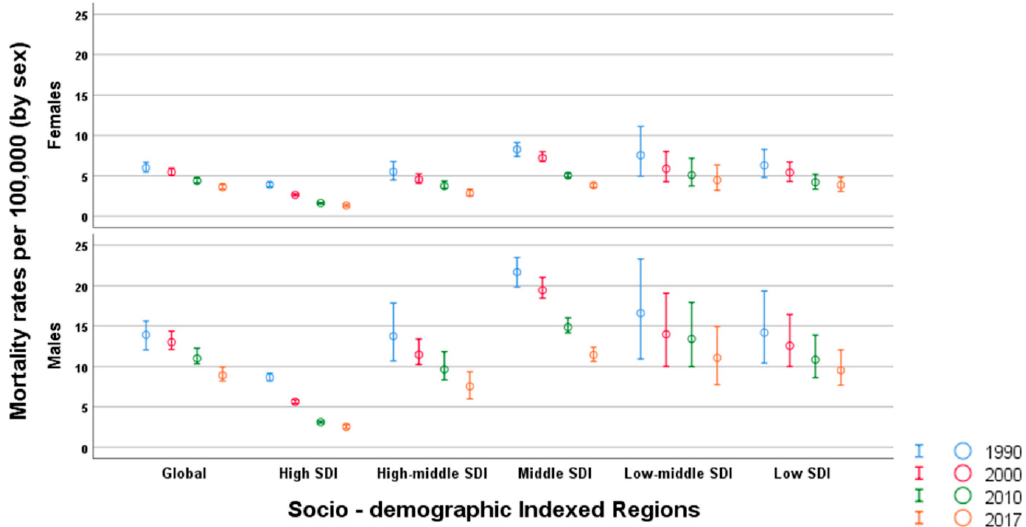
Figure 5. Mortality trends due to pedestrian road traffic injuries by sociodemographic indices 1990 – 2017.